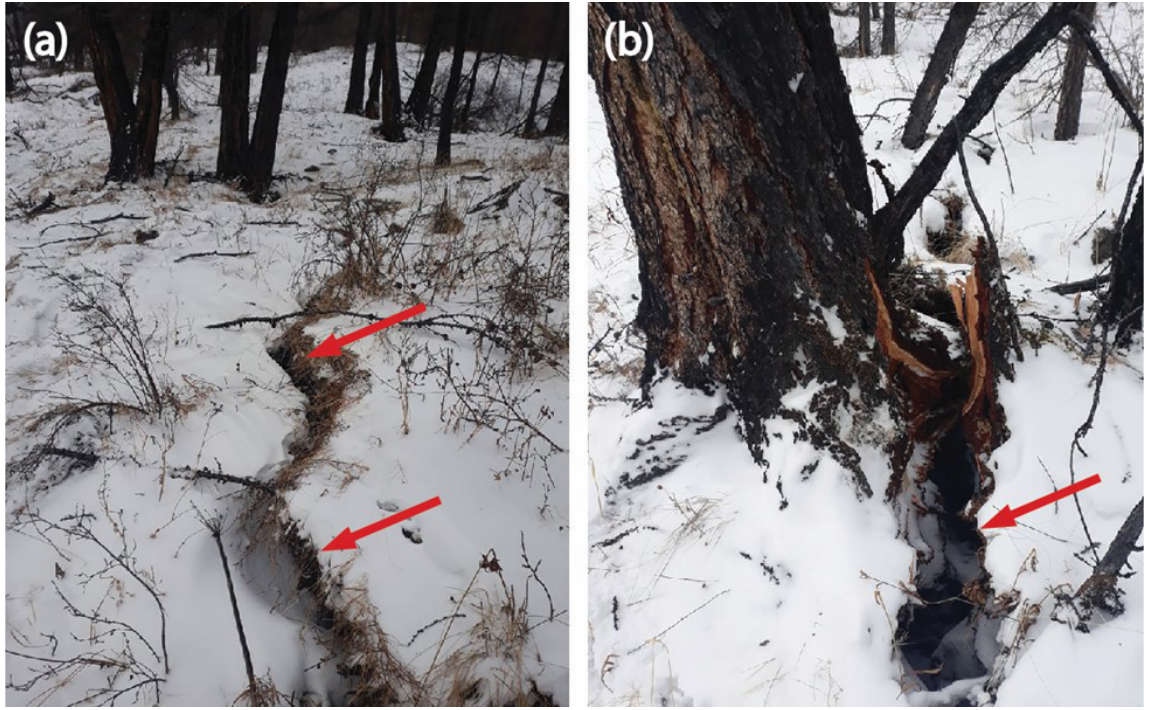
Fig. 6. Cracks in the Western Range. (a) an elongated crack with width of ~10 cm is marked by the red arrows. (b) a big tree is broken by the co-seismic event. The local name of the location is the Artsatiin Khash. Photos by